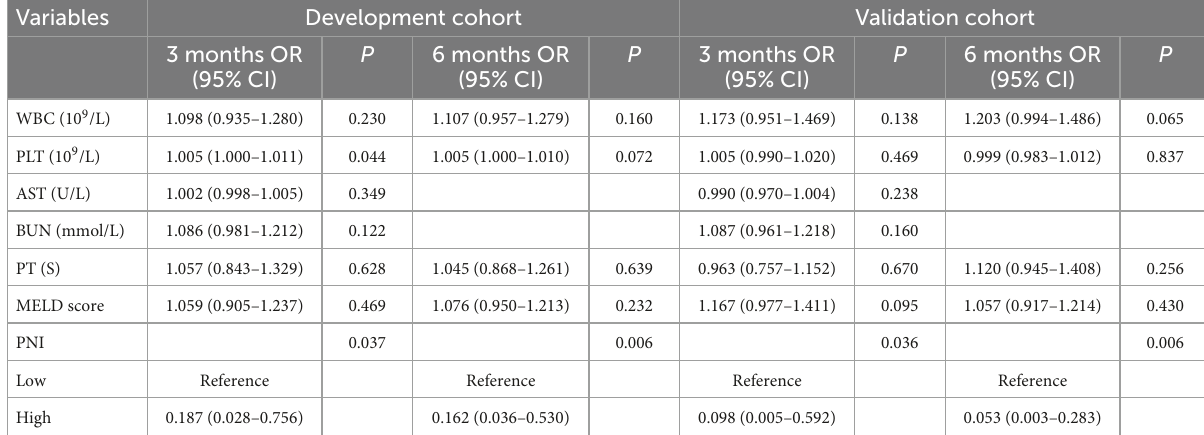
TABLE 3 Factors correlated with 3-month, and 6-month mortality in multivariate analyses in patients with decompensated liver cirrhosis in the development cohort and validation cohort. Variables Development cohort Validation cohort